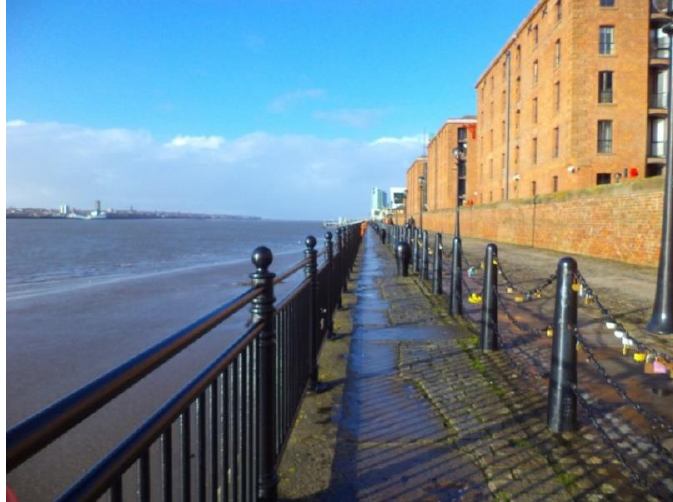
Figure 5. Example of blue spaces promoting respect and social inclusion (P20) (Albert Dock, Liverpool).